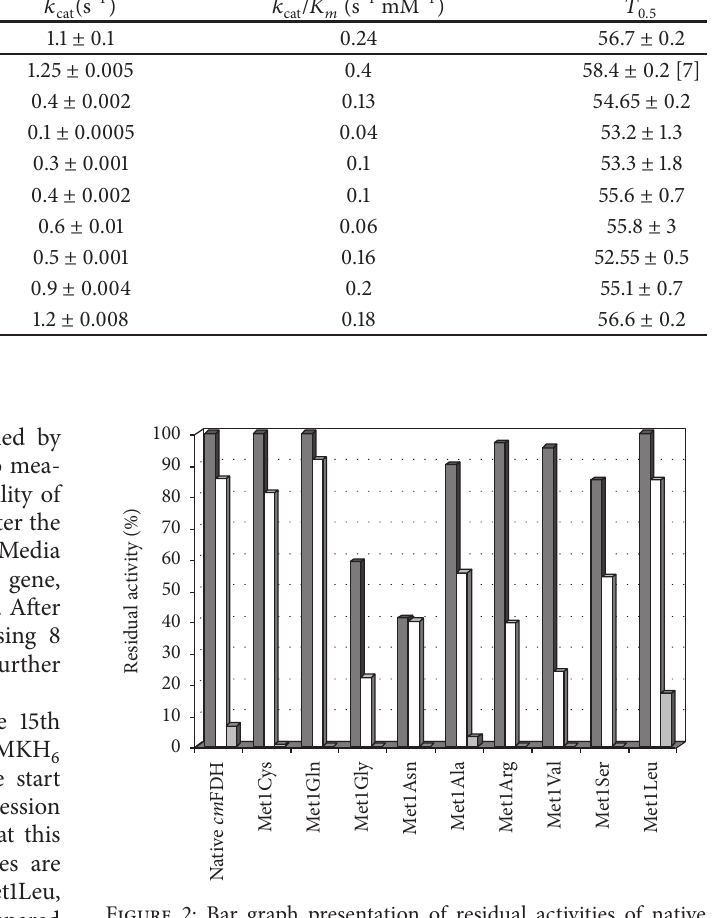
Figure 2: Bar graph presentation of residual activities of native cm FDH and site saturation mutants at position 1 after incubation in 50 (dark grey), 55 (white),and 60 ∘ C (lightgrey) for 20min. Residual activities were expressed relative to activities in room temperature (25 ∘